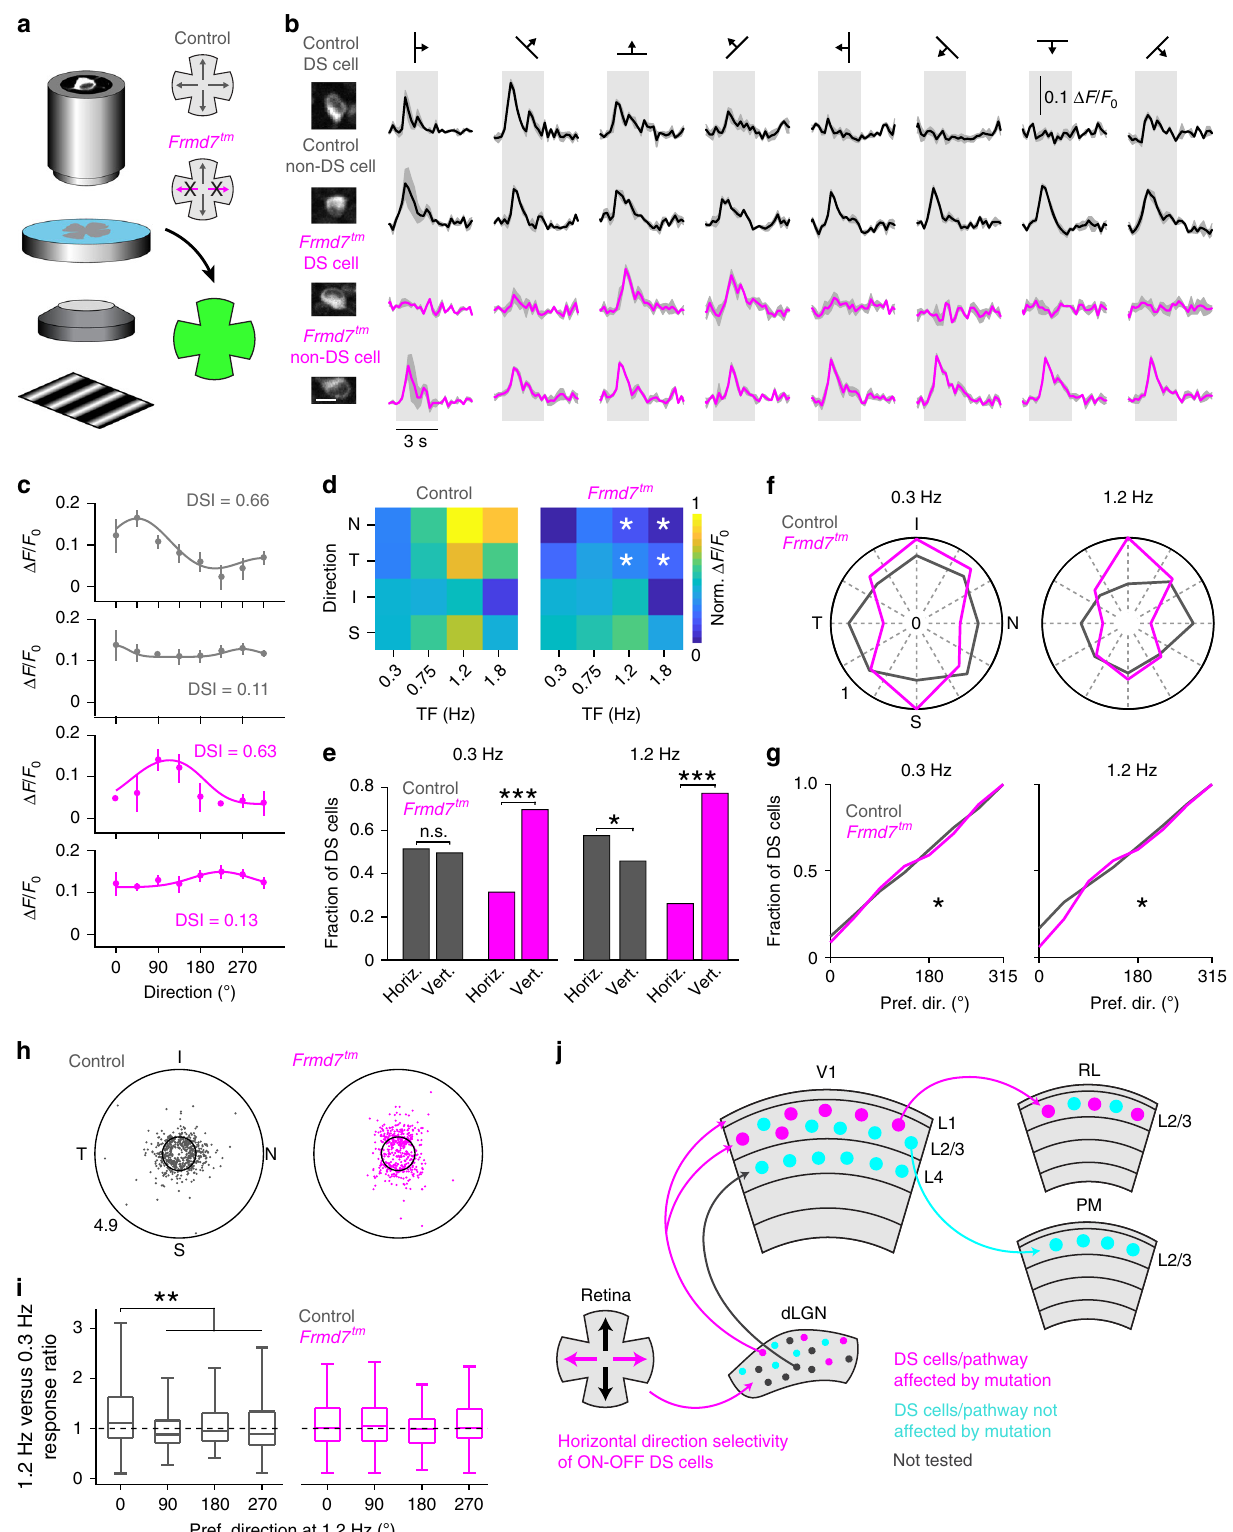
visuo-tactile space near the face of the mouse. Interestingly, the ventral intraparietal area of the human posterior parietal cortex, which is referred to as the dorsal stream of vision, also contains visual and tactile maps, and is focused on processing the face- centered sensory space 50 . In macaque monkeys, this area contains